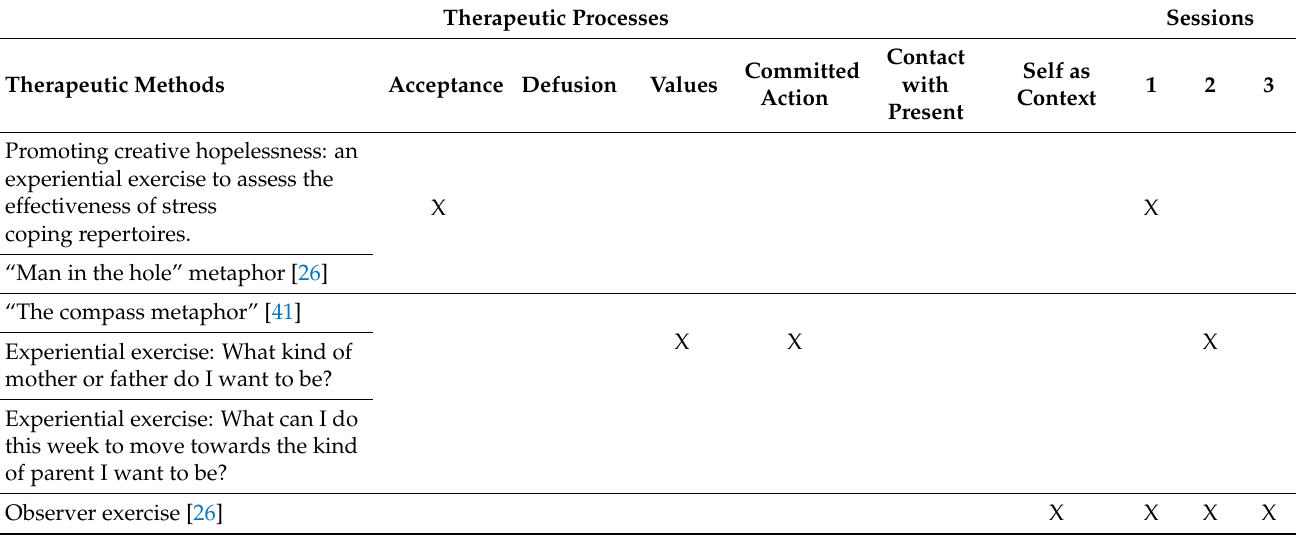
Table 1. Description of the clinical trial intervention